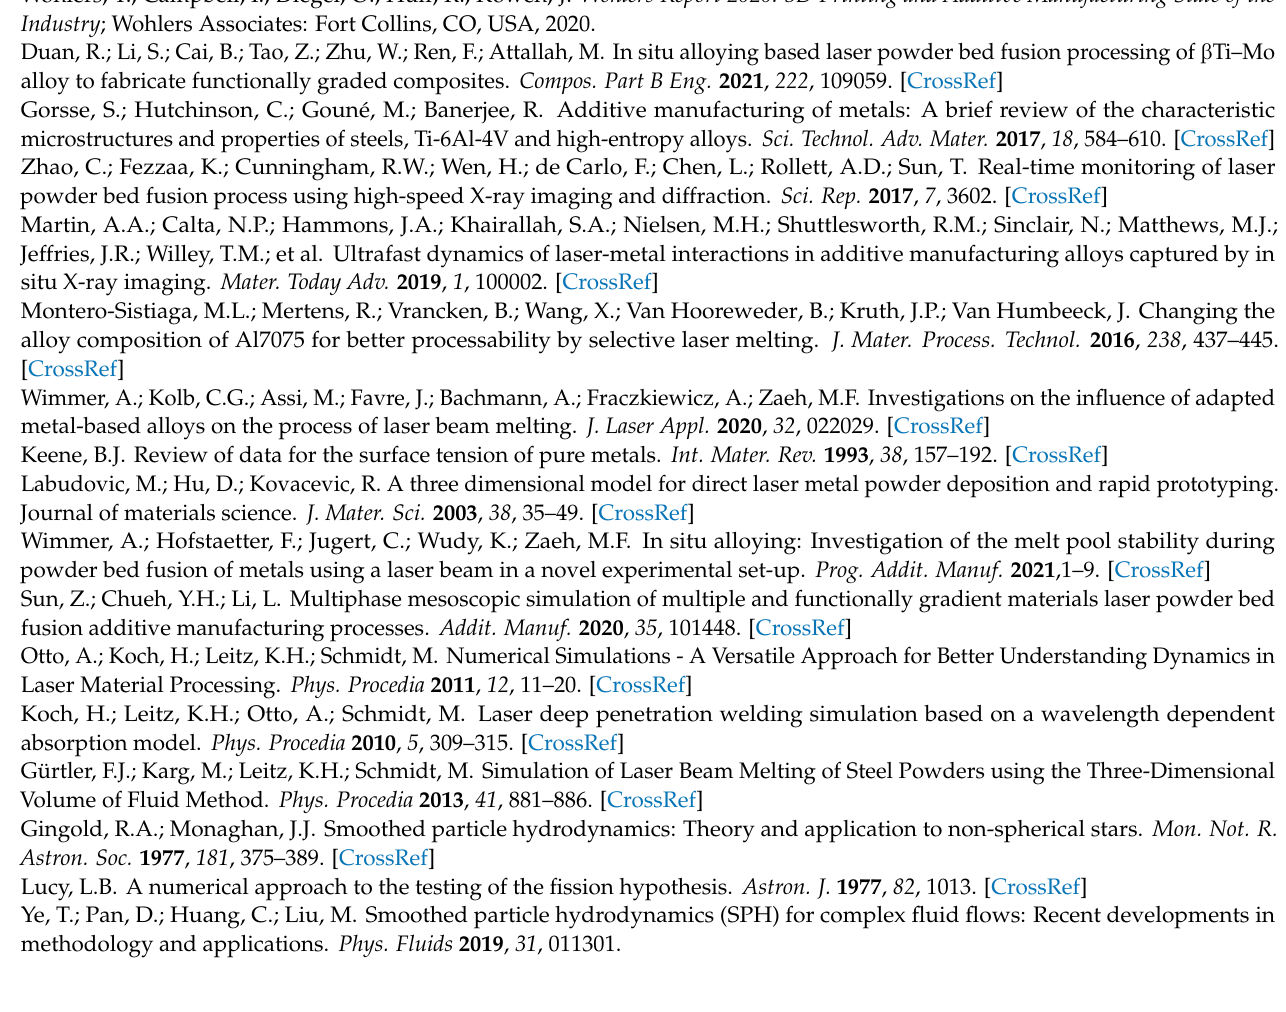
It should be noted that following common practice [56] , the dynamic viscosity given in Tables A1 and A2 includes a multiplication factor of 20 to stabilize the molten pool under surface